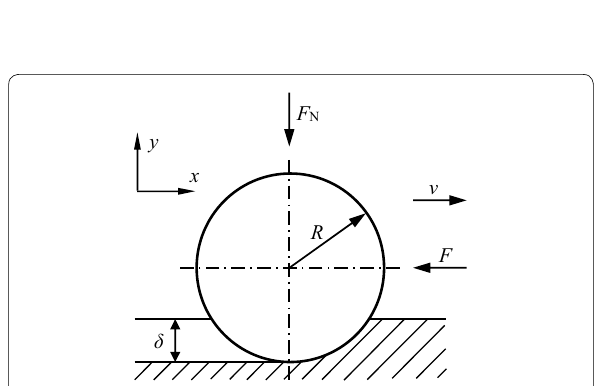
Figure 9 Schematic diagram for sliding contact